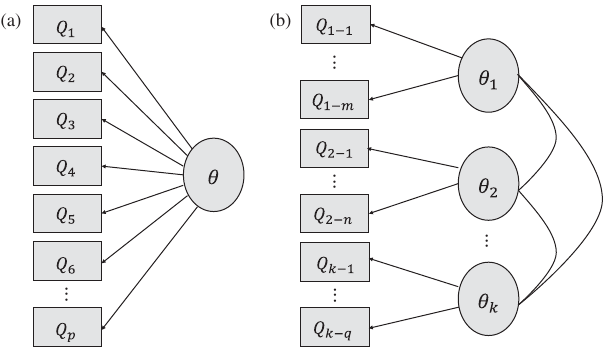
FIG. 1. (a) Unidimensional IRT model, (b) multidimensional IRT